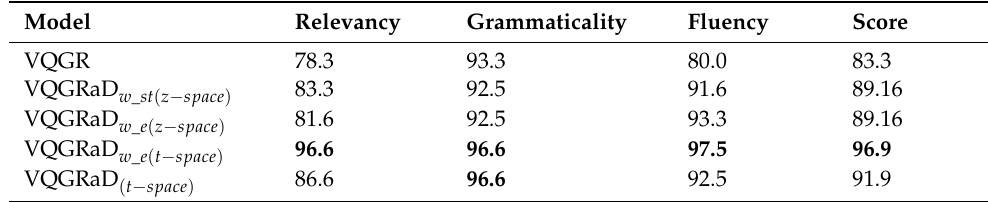
Table 4. Results of the manual evaluation of the best VQGRaD models and the VQG baseline system. “Relevancy”, “Fluency”, and “Grammaticality” are rated on a 1–3 scale (3 for the best). “Score” is the average of relevancy, fluency, and grammaticality scores. All numbers are normalized (divided by 60). The perfect score is 100.